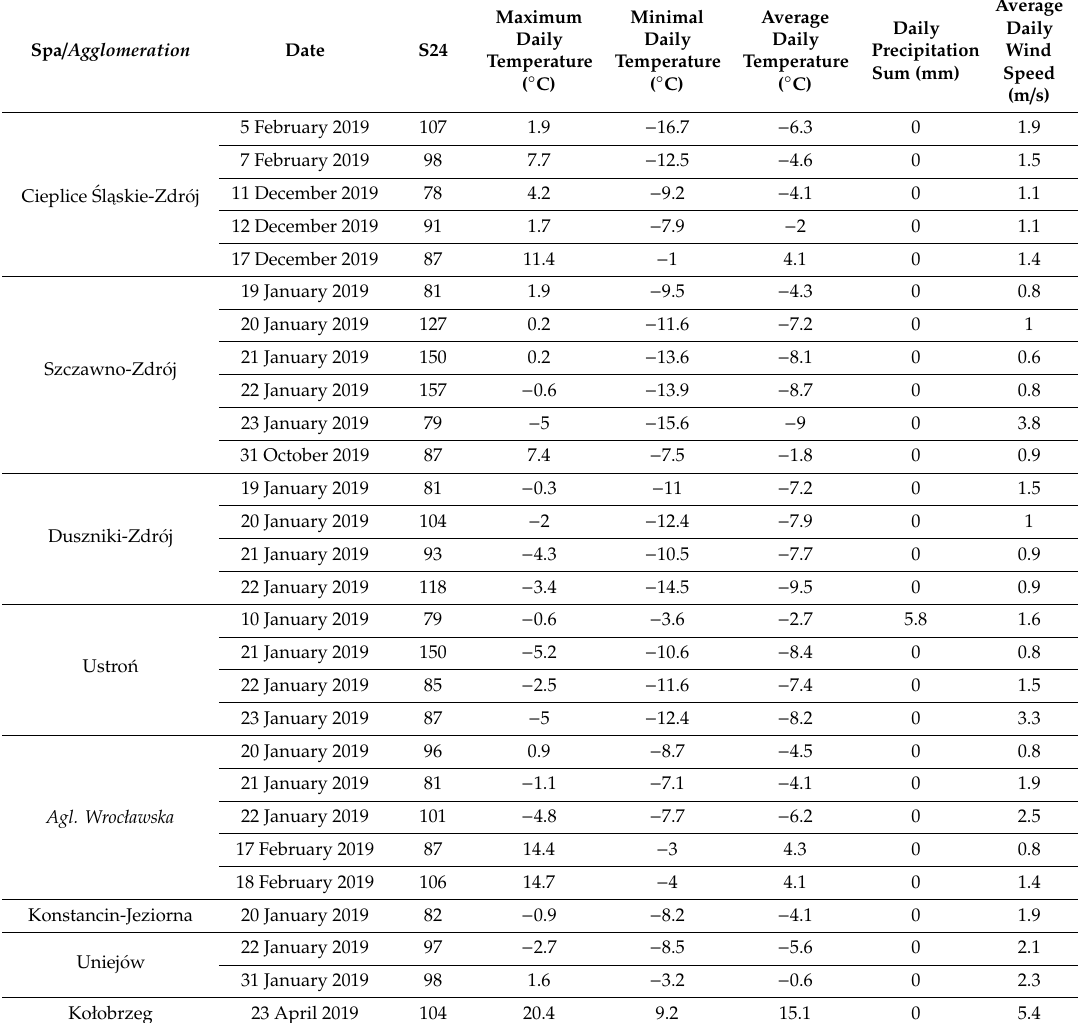
Table 7. Summary of episodes of increased PM 10 levels in 2019.